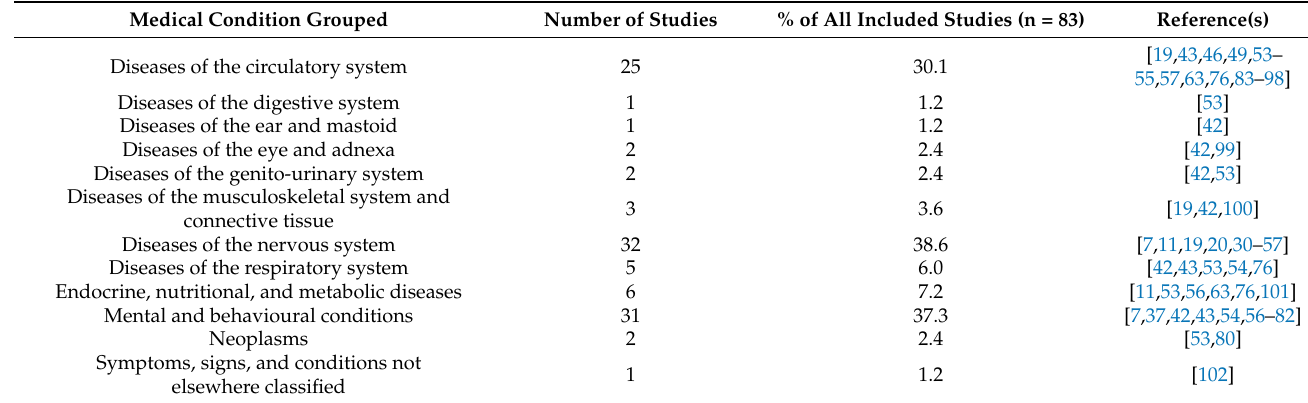
Table 3. Grouped medical condition by included